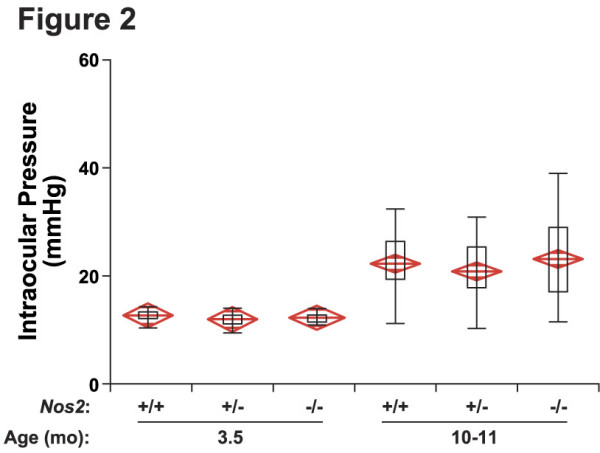
NOS2 deficiency does not alter IOP. The IOP distributions of mice of each genotype overlap extensively. The boxes show the upper and lower quartiles and the bars show the extremes including outliers. The centerline of each diamond is the mean with the upper and lower points of each diamond representing the 95% confidence intervals of the mean. Mean ± s.e.m in mm Hg, number of eyes examined; 3.5 months, Nos+/+ 12.6 ± 0.24, 18; Nos+/- 11.9 ± 0.30, 19; Nos-/- 12.2 ± 0.19, 19; P value for all comparisons > 0.08; 10–11 months, Nos+/+ 21.9 ± 0.87, 39; Nos+/- 21.0 ± 0.95, 32; Nos-/- 23.6 ± 1.3, 30, P value for all comparisons >0.09.